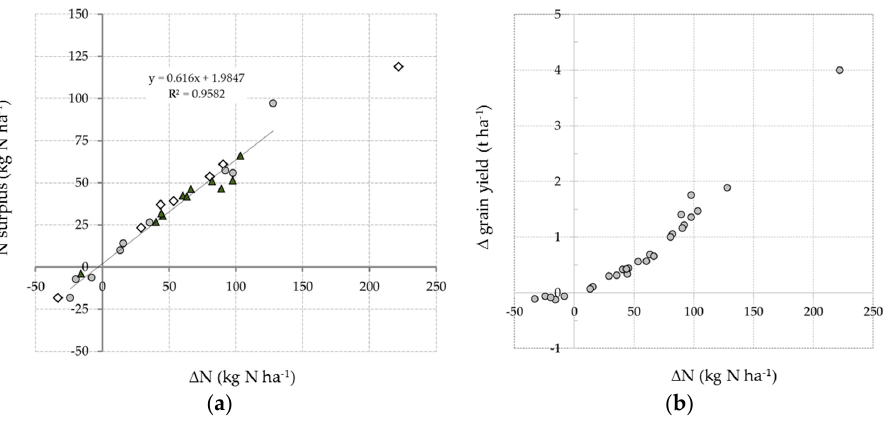
Figure 3. ( a ) Relationship between Δ N (difference of N fertilizer supply between N Econ and N Bal = 0 ) and N surplus; ( b ) relationship between Δ N and Δ grain yield (yield difference between N Econ and N Bal = 0 ). Different symbols in Figure 3a indicate experimental years (diamonds: 2011, circles: 2012, triangles: 2013).